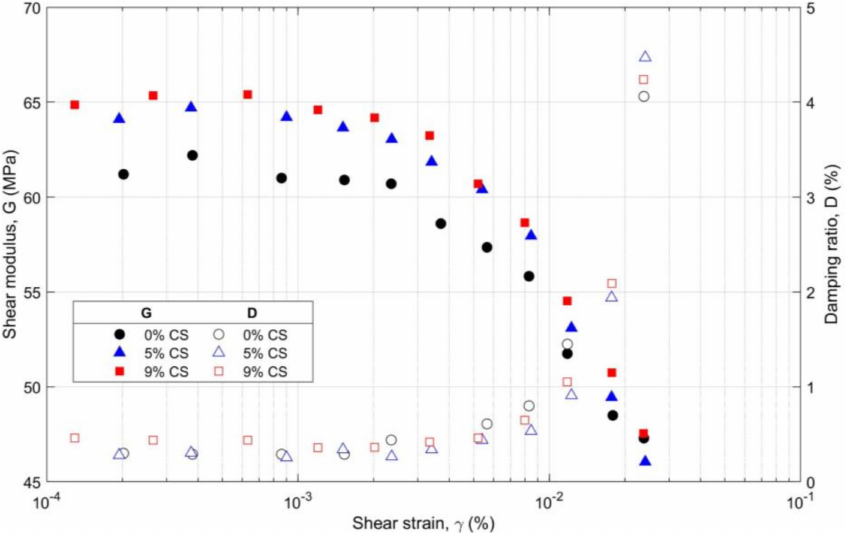
Figure 9. Experimental shear modulus (left axis) and damping ratio (right axis) versus shear strain from resonant column tests on CS-treated and untreated sand (data from